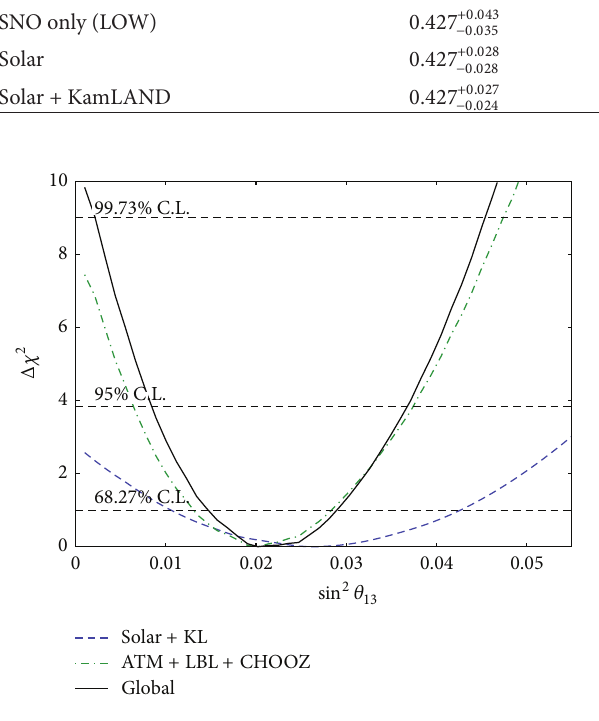
Figure 17: In this picture, taken from [154], the final energy spectrum derived from Borexino’s analysis (red points) is repre- sented and compared with the Monte Carlo predictions (blue and purple bands) obtained using the MSW-LMA neutrino oscillation model and the standard solar models in the versions corresponding, respectively, to the high metallicity (BPS09(GS98)) and the low metallicity (BPS09 (AGS05))